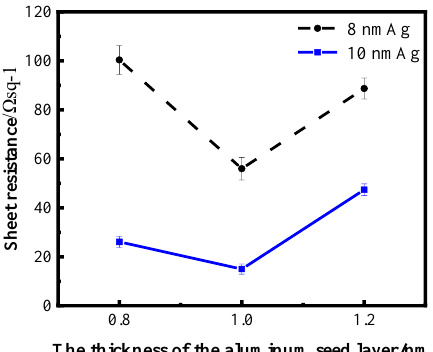
Figure 4. Curves of sheet resistance of silver film with different thickness on an aluminum seed layer.